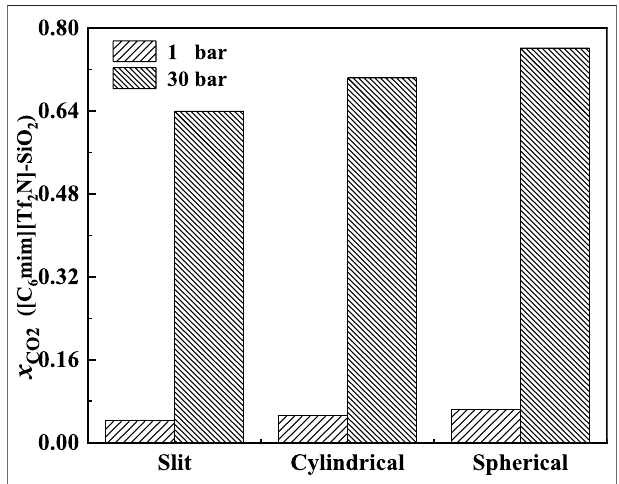
FIGURE 11 | Calculated CO 2 solubility of [C 6 mim] [Tf 2 N] con fi ned in different-shaped poresat 298.15 Kand 1and 30 bar(the widthofslit-shaped pore and the diameter of cylindrical pore and spherical cavity are all 5